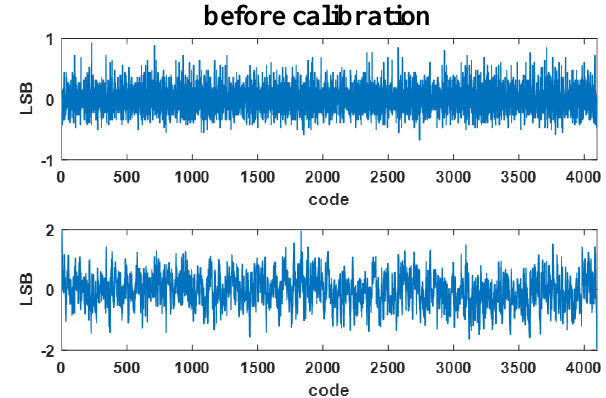
Figure 12. DNL and INL before calibration.